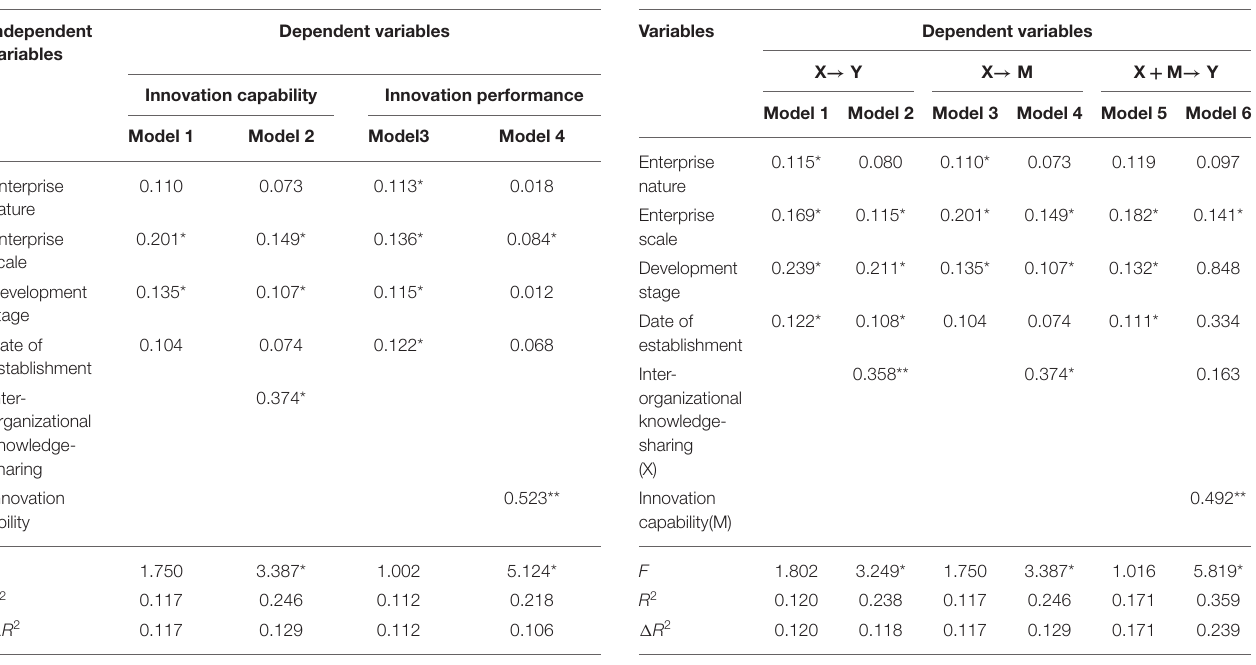
TABLE 7 | Main effect test. TABLE 8 | Mediator effect